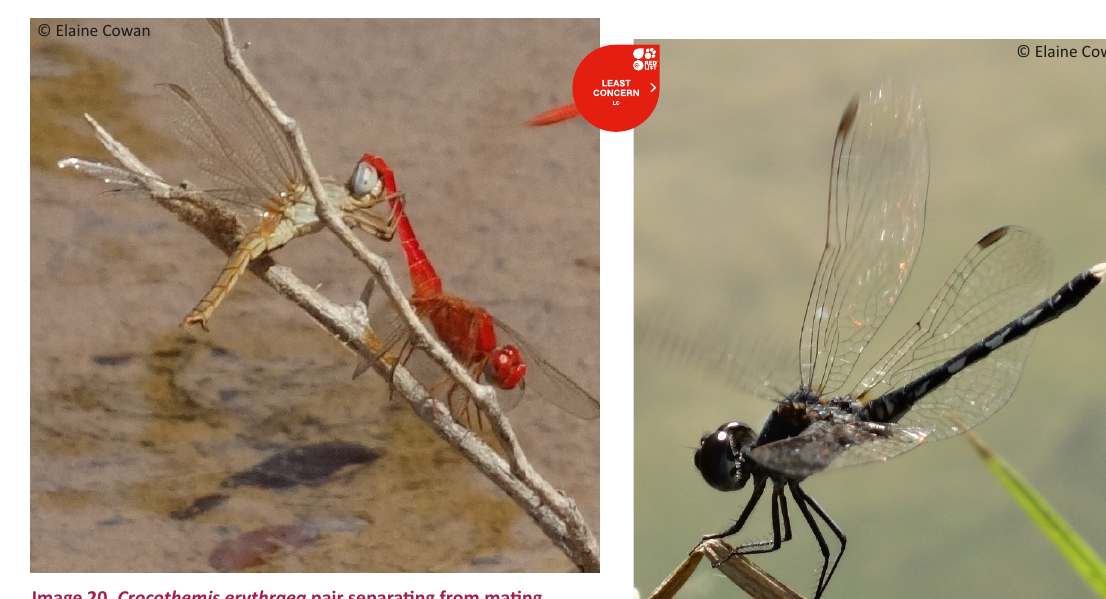
Image 18. Male Crocothemis erythraea , 2 June 2014. Scarlet with broad abdomen with no black markings. Eyes bluish below. Reddish legs. Amber patch at wing bases and long pale pterostigmas.